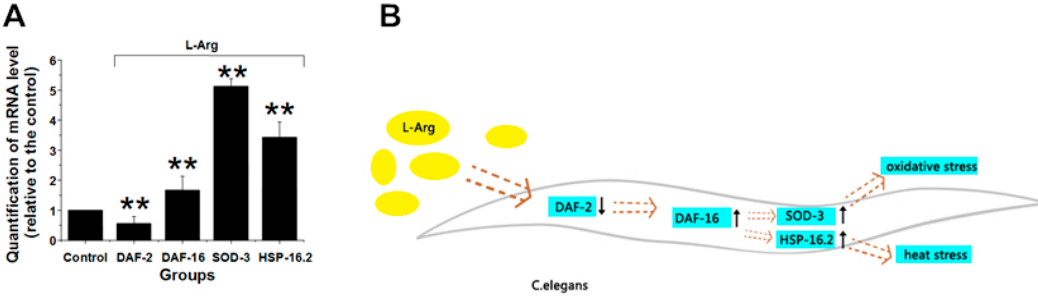
Figure 4. The regulatory effects of L-Arg on ageing-associated genes in C. elegans . ( A ) Worms were treated with or without 1 mM L-Arg. RT-PCR was performed to quantify the expression of the ageing-associated genes in C. elegans . Data are presented as mean ± SE (** p < 0.01); ( B ) Proposed